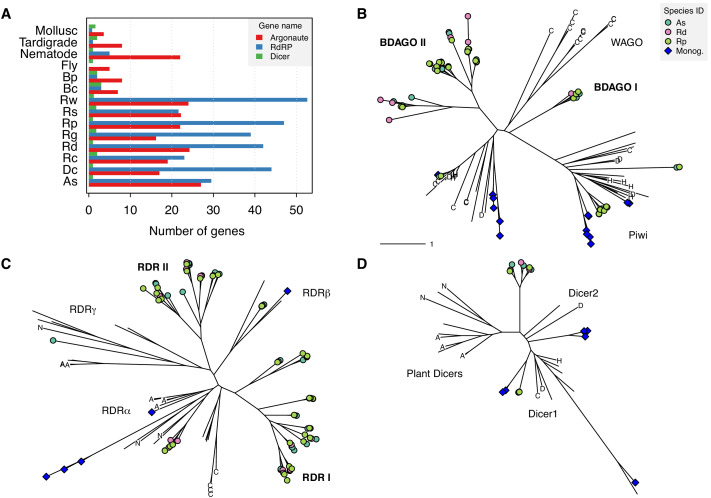
Expansion of TE silencing pathways in bdelloid rotifers.(A) Copy number variation for RNAi gene families Argonaute (Ago/Piwi, red), RNA-dependent RNA polymerase (RdRP, blue) and Dicer (green) in bdelloids compared to other protostome groups. Proteins are identified based on the presence of key identifying domains (see Materials and methods). Species codes for rotifers: Bc, B. calyciflorus; Bp, B. plicatilis HYR1; Dc, D. carnosus; As, A. steineri; Rg, R. magnacalcarata; Rs, R. socialis; Rc, R. macrura; Rd, R. sordida; Rw, R. sp. ‘Silwood-1’; Rp, R. sp. ‘Silwood-2’. Maximum likelihood unrooted phylogenies are then shown for (B) Argonaute, (C) RdRP and (D) Dicer gene copies identified in A. steineri, R. sordida and R. sp. ‘Silwood-1’ 10x haploid assemblies, aligned with orthologs from representative species from across the eukaryotes. Blue symbols indicate copies identified in the monogonont B. plicatilis, and letters on tips show selected reference species to aid visual orientation: ‘C’, C. elegans; ‘H’, human; ‘D’, D. melanogaster; ‘N’ N. crassa; ‘A’, A. thaliana. Some clade names are also shown where relevant; ‘WAGO’ indicates the worm-specific cluster of Ago genes in the Argonaute phylogeny. ‘BDAGO I/II’ and ‘RDR I/II’ indicate putative bdelloid-specific clades of Argonaute and RdRP proteins, respectively.Figure 7—source data 1.RNAi gene family expansions.Figure 7—source data 2.Argonaute, Dicer, and RdRP alignments and phylogenies.